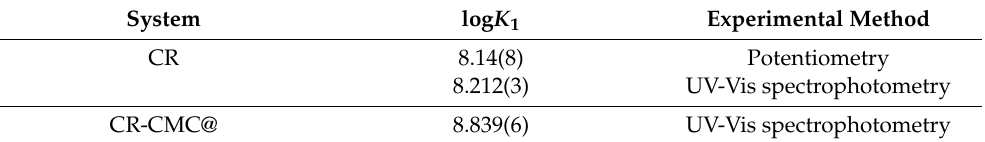
Table 4. Protonation constant referring to the cresol red protonation step: CR 2 − + H + = H(CR) − at T = 298 K and I = 0.1 M (KCl). Values in parentheses are standard deviations on the last significant